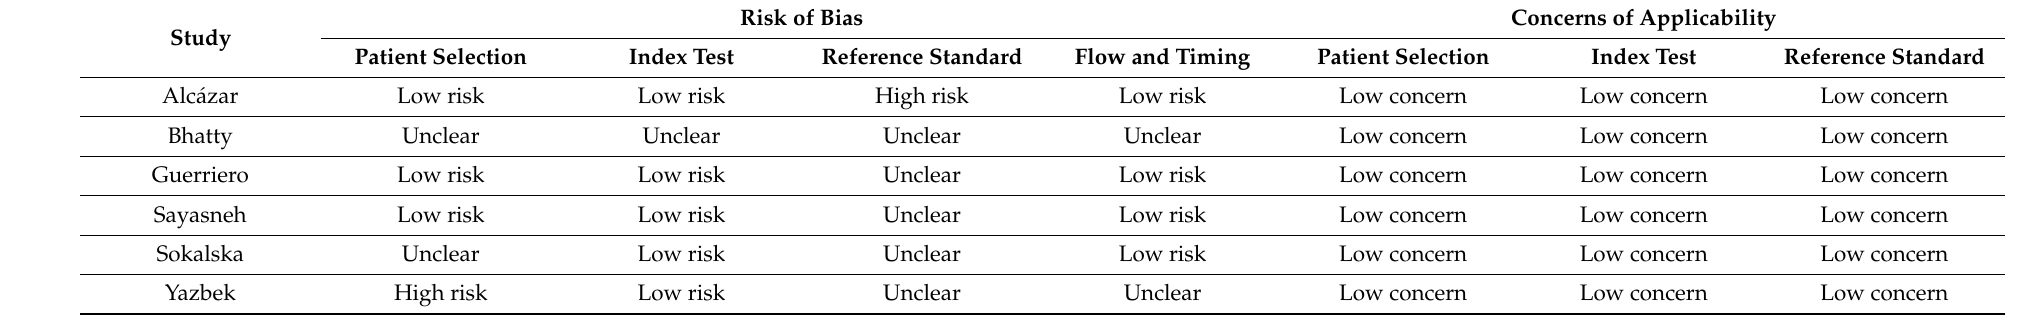
Table 2. QUADAS-2 assessment of the studies included in the